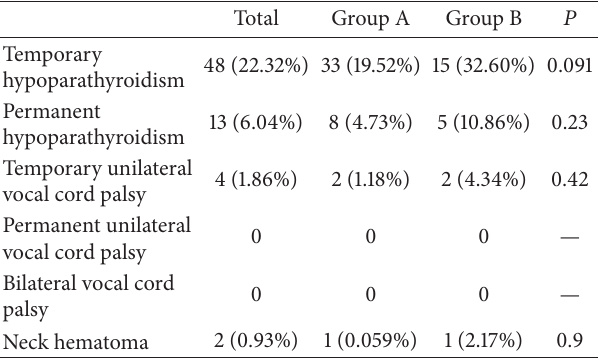
Table 2: Total thyroidectomy: